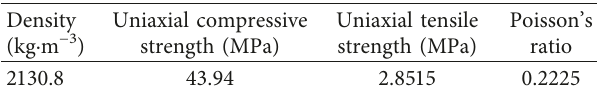
Table 3: Physical and mechanical parameters of sandstone. Density